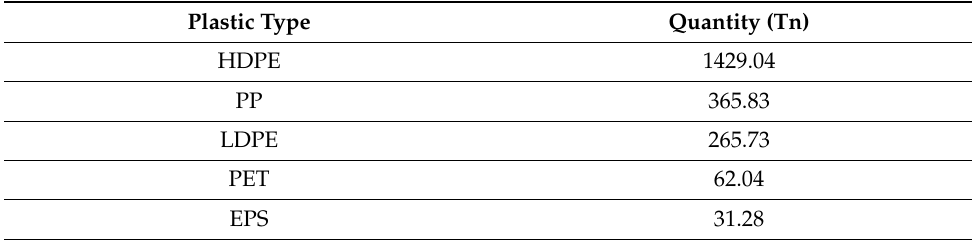
Table 2. Quantity of waste identified by type of